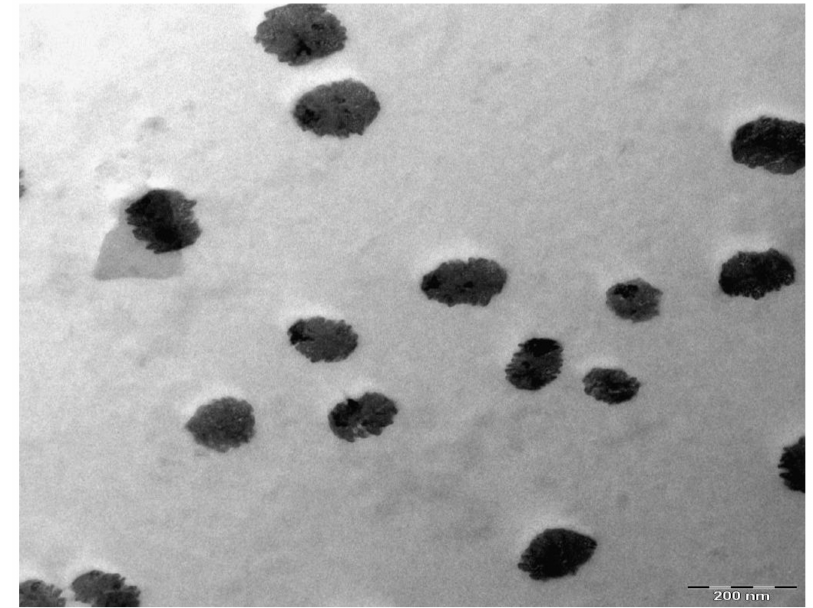
Figure 7. TEM images of silver nanoparticles for PB4 sample at room